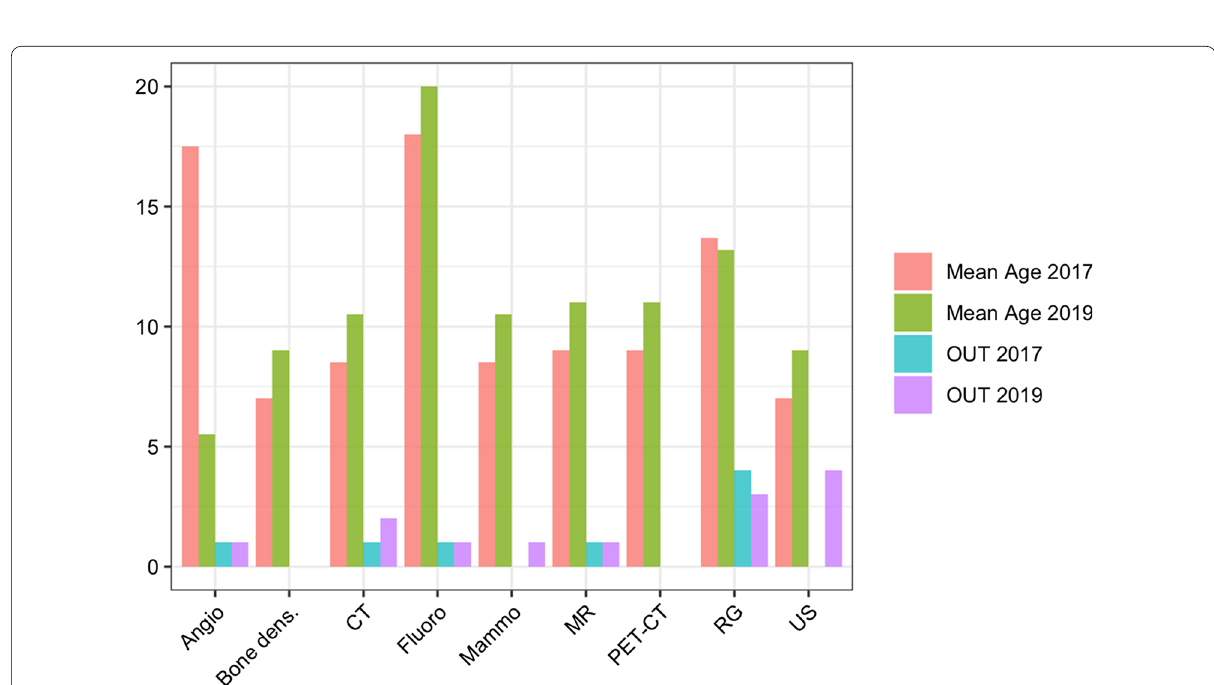
Fig. 1 Increasing age of modalities in a department with the consequence that without appropriate investments a relevant part gets outside the ESR recommendations, e.g. USA